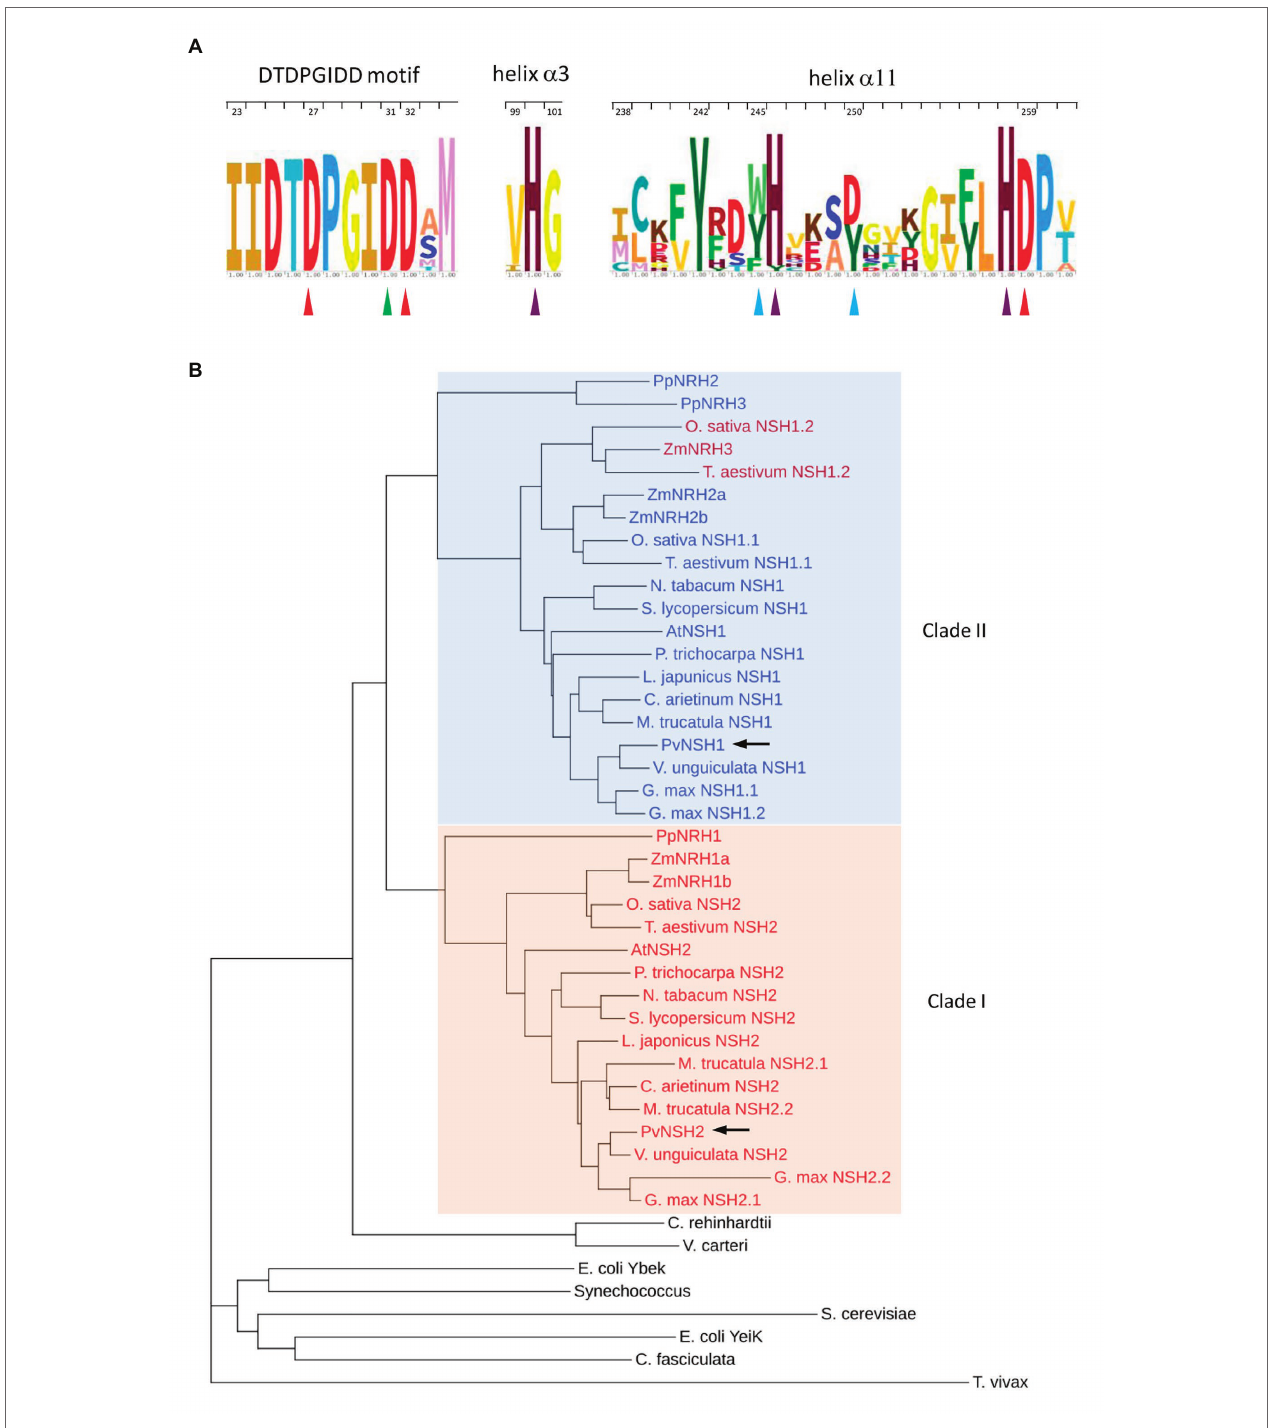
FIGURE 1 | Conservation of the amino acid sequences of nucleoside hydrolases (NSHs) from plants and cladogram. (A) Sequence logos of the DTDPGIDD motif and the α 3 and α 11 helix. Red triangles indicate the Asp residues involved in calcium ion coordination. The Asp-binding 2-OH group of ribose is highlighted with a green triangle. Turquoise triangles indicate the crucial residues involved in substrate binding in plants NSHs. Purple triangles highlight the conserve histidines. Residues are numbered according to PvNSH1 sequence. (B) Cladogram highlighting the two distinct clades. The color of the text indicate the subclass [blue: subclass II (Asp-250 + Trp-245); red: subclass Ia (Tyr-250 + Tyr-245), and dark red: subclass Ib (Asp-250 + Trp-245), as proposed in Kopecna et al., 2013]. Phaseolus vulgaris nucleosidases are highlighted in with